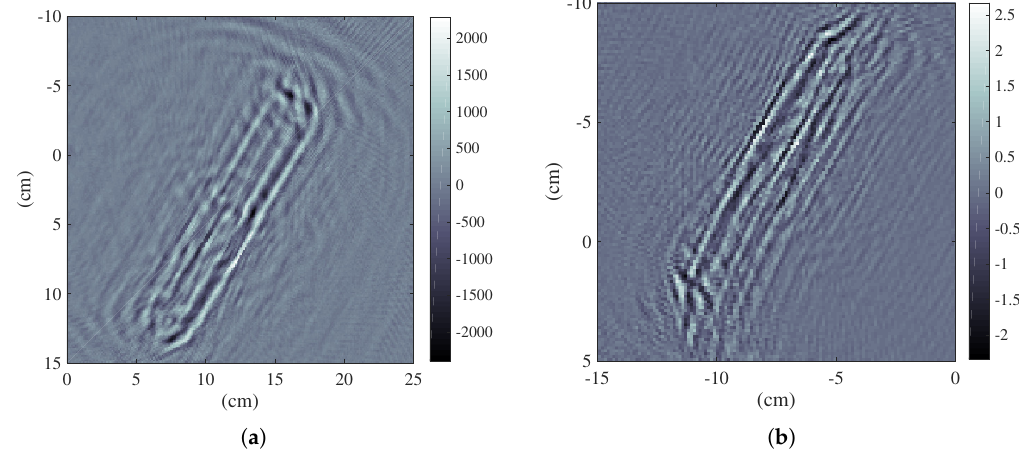
Figure 8. Reconstructed radar images and pictures of the targets. ( a ) The near-field radar image of the metal pen and pencil case. The ’ b ’ shaped pen is overlapped with a zip-lined pencil case; ( b ) The radar image of the metal pen and pencil case in the far